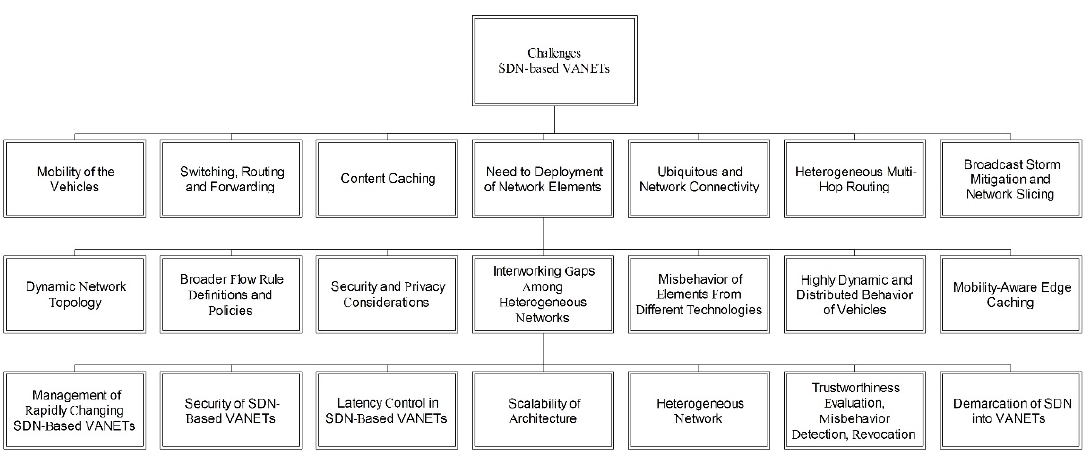
Figure 24. The taxonomy of the SDN-based VANET challenges.